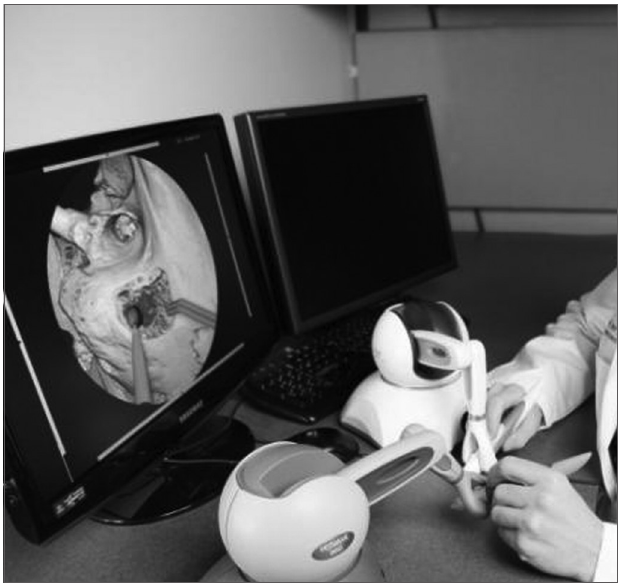
Figura 2. Simulador virtual de dissecação do osso temporal. Virtual Temporal Bone Project. Note controles que possibilitam sensação de toque e força (force